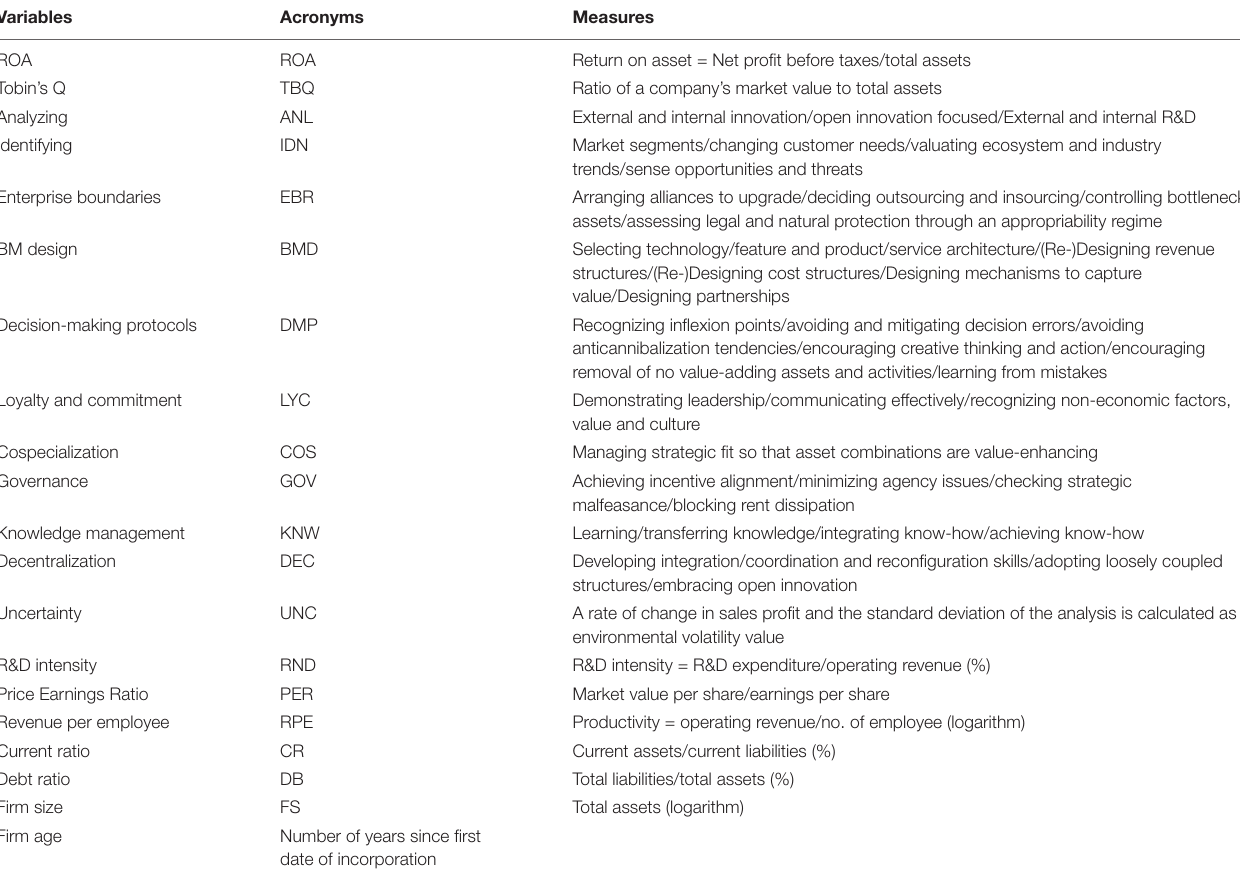
TABLE 2 | Variables and